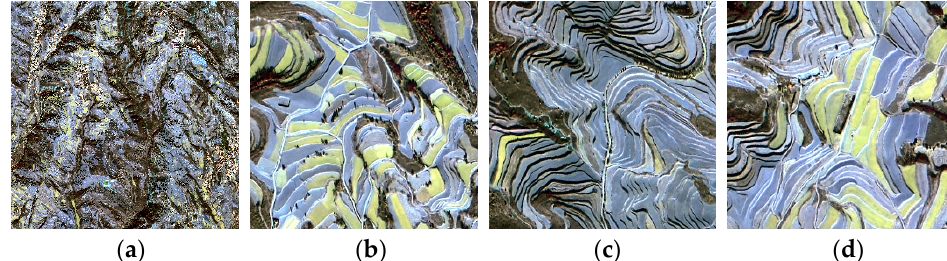
Figure 5. Fusion image of GF-2 sample area and fusion images of three test areas outside the sample area. ( a ) Sample area image; ( b ) test area 1 image; ( c ) test area 2 image; ( d ) test area 3 image. The sample area image is 3400 × 3400 pixels in size. The test area 1, 2, and 3 images are all 500 × 500 pixels in size.